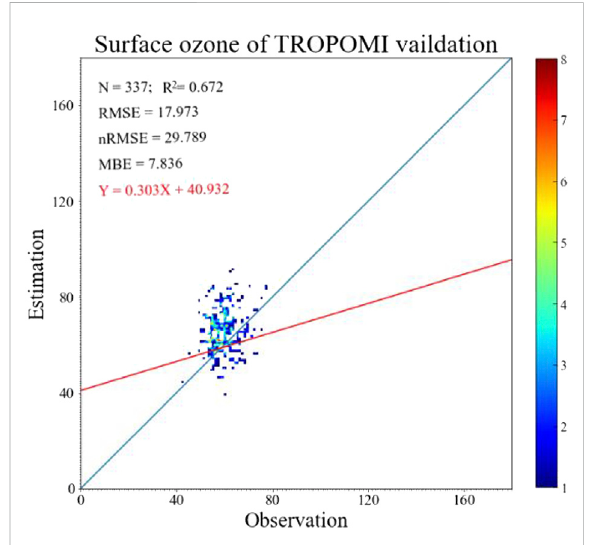
FIGURE 2 Validation result of the TROPOMI surface-level ozone concentration map in 30 km. N means total matched points, R 2 is the correlation coef fi cient, RMSE is the root-mean-square error, nRMSE is the normalized root-mean-square error, and MBE representsmean biasederror. Thesolidblueline isthe1:1 line.The solid red line is the fi tting line of observation and surface ozone of TROPOMI, and the equation marked in red is the fi tting formula, where X represents surface ozone observation and Y represents surface ozone of TROPOMI. The color bars in (a)-(l) indicate the number of samples in the 1.5 μ g/m 3